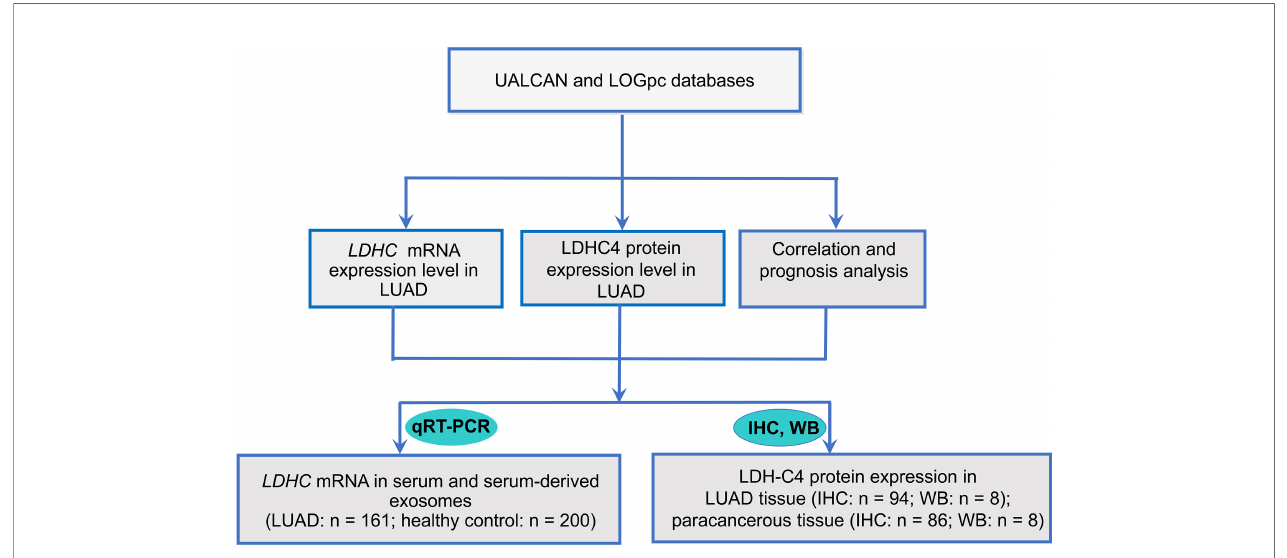
FIGURE 1 | Flowchart of research design. IHC, immunohistochemistry; qRT-PCR, quantitative real-time PCR; WB, Western